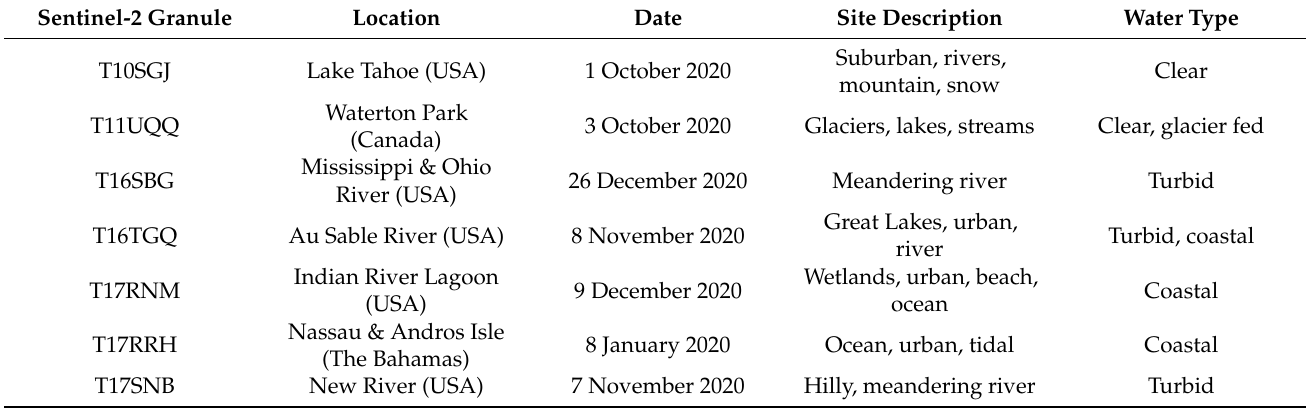
Table 1. Overview and description of the study sites and associated Sentinel-2